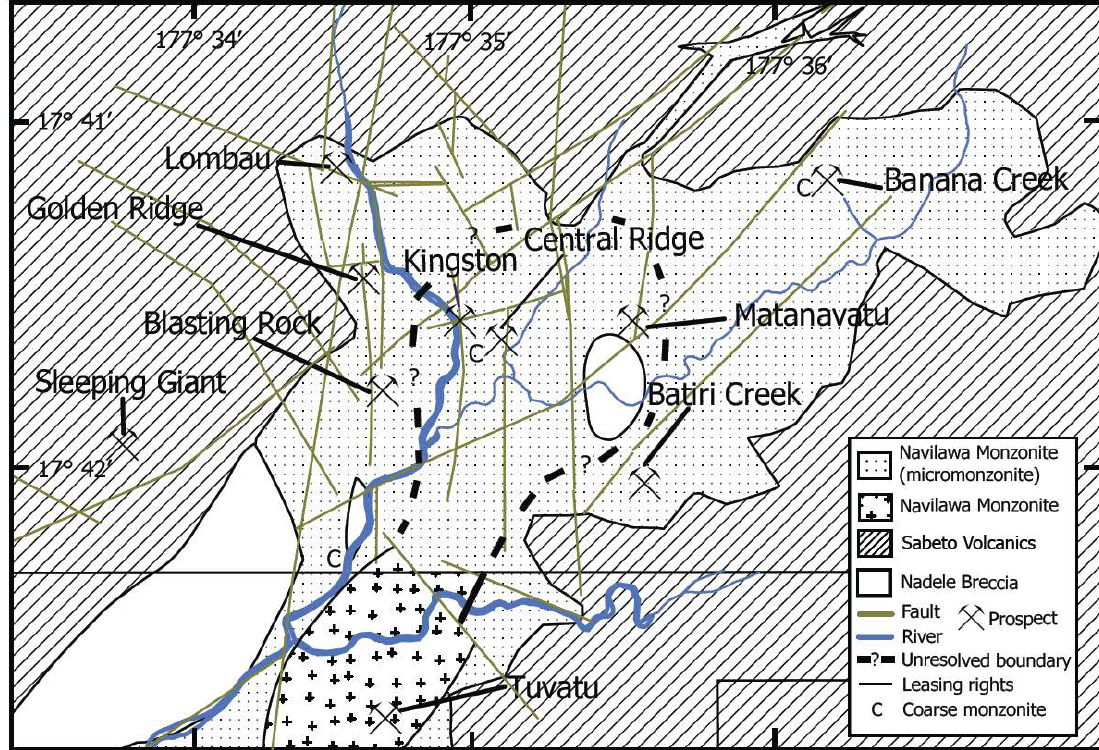
Figure 2. Simplified geologic map of the Navilawa caldera showing the location of the various porphyry Cu- and epithermal-style Au prospects. Drill hole locations are shown as 1 (TNDH001), 2 (TNDH002), 4 (TNDH004), 6 (BCDH6), 7 (BCDH7), and 8 (BCDH9). Sampling by Continental Resources, aimed at assessing the gold potential near Kingston, discovered the best results at Central Ridge. Soil channel samples yielded 11 m at 4.45 g/t Au and 1.43% Cu, 14 m at 1.05 g/t Au and 1.04% Cu, and 12 m at 2.33 g/t Au [17]. Drilling completed at Central